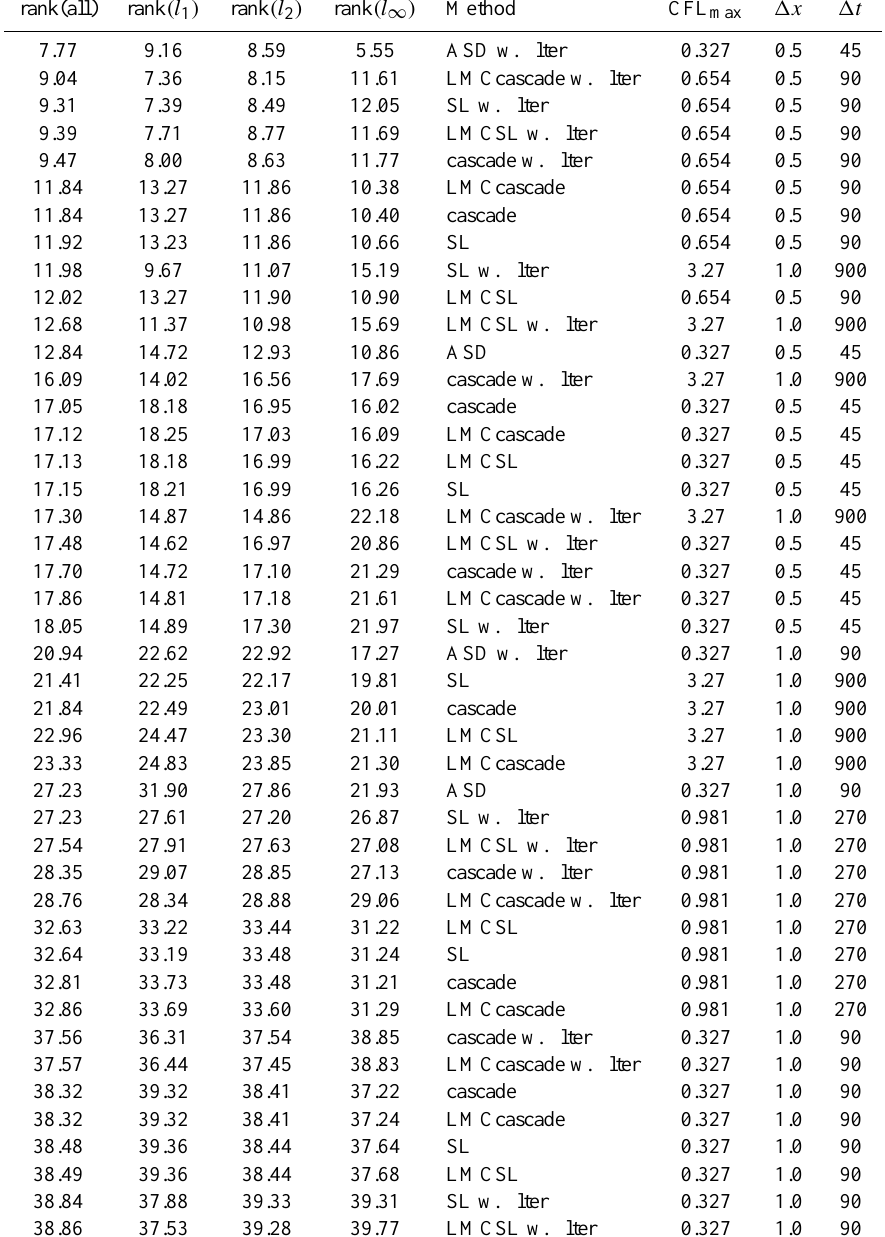
Table 3. Raking results for the rotating cone with urban chemistry. Showing rank of the ranked error measures, rank of error measure l 1 , l 2 , and l ∞ followed by method, maximum Courant number, grid resolution, and time